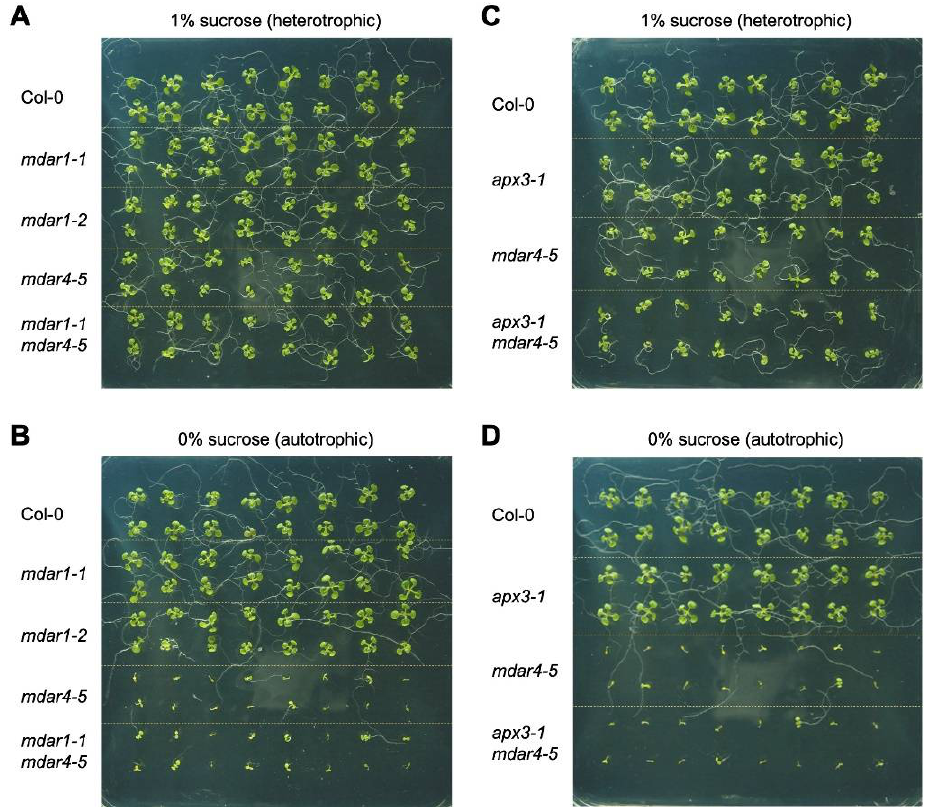
Figure 7. Autotrophic growth of Arabidopsis thaliana mutants lacking AthMDAR1, AthMDAR4, and/or AthAPX3. Arabidopsis thaliana wild-type plants (Col-0) and knockout mutants were grown on half-strength MS medium, with ( A , C ) or without ( B , D ) 1% sucrose, for 10 days and then photo- graphed. ( A , B ) Representative pictures of 10-day-old wild type, mdar1-1 , mdar1-2 , mdar4-5, and mdar1-1 mdar4-5 . ( C , D ) Representative pictures of 10-day-old wild type, apx3-1 , mdar4-5, and apx3-1 mdar4-5 .